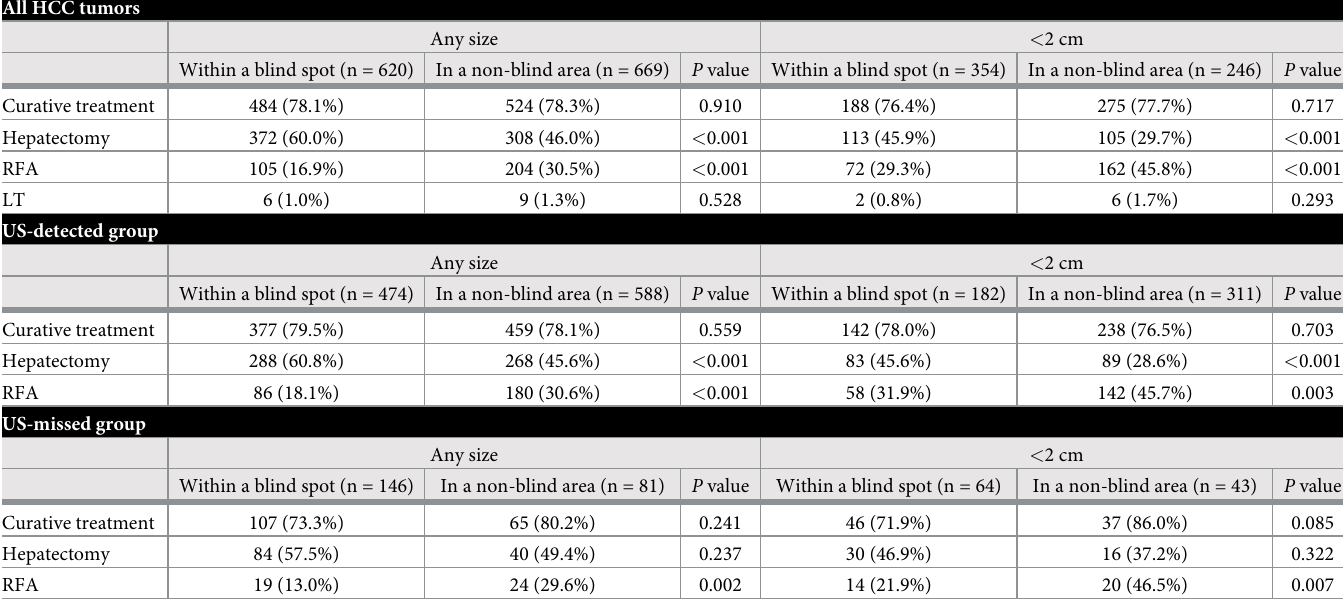
Table 4. Differences in initial treatment by HCC tumor size and